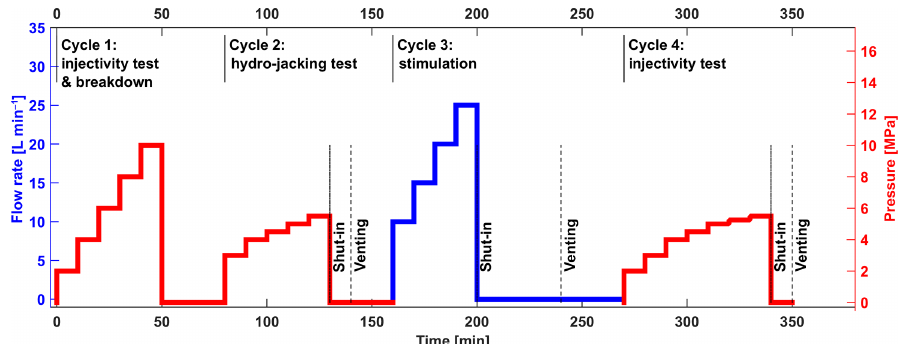
Figure 6. Injection protocol for hydro-shearing experiments. Red curves denote pressure controlled injections. (Cycle 1), blue curves flow rate controlled injections (Cycle 2 and 3). The total volume injected is 1m 3